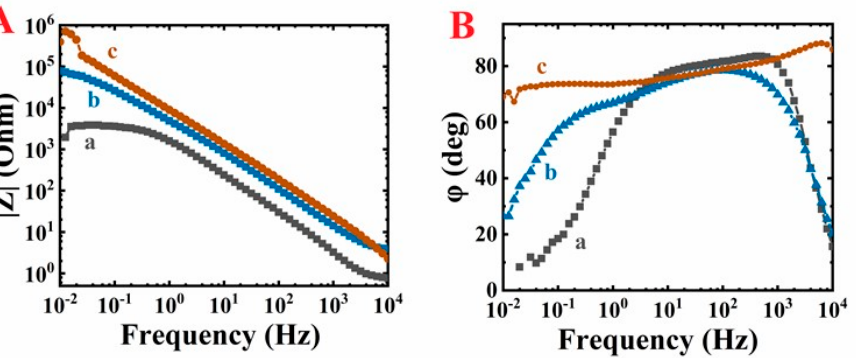
Figure 3. EIS Bode plots of impedance ∣ Z ∣ ( A ) versus frequency, ( B ) phase angle versus frequency for (a) uncoated and coated substrates, (b) CAD sample, and (c) HiPIMS sample.